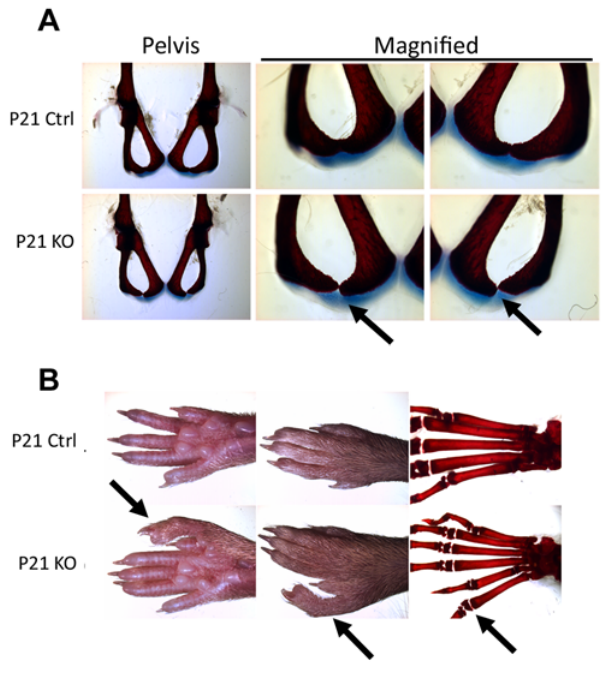
Figure 5. Minor defects observed in Atrx Col2Cre mice. (A) Pelvis phenotype of P21 control and Atrx Col2Cre mice. Arrows indicate the site of delayed ossification in mutant mice. (B) Hind limb of mutant mouse with one additional digit, before and after skeletal preparation to stain for cartilage (blue) and bone (red). The additional digit is indicated by an